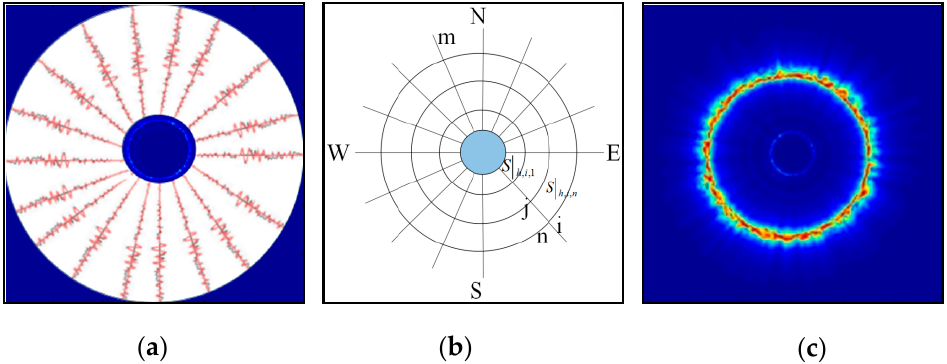
Figure 3. Schematic diagram of acoustic wave scanning data processing. ( a ) Scanning data, ( b ) circular matrix, ( c ) circumferential visualization.